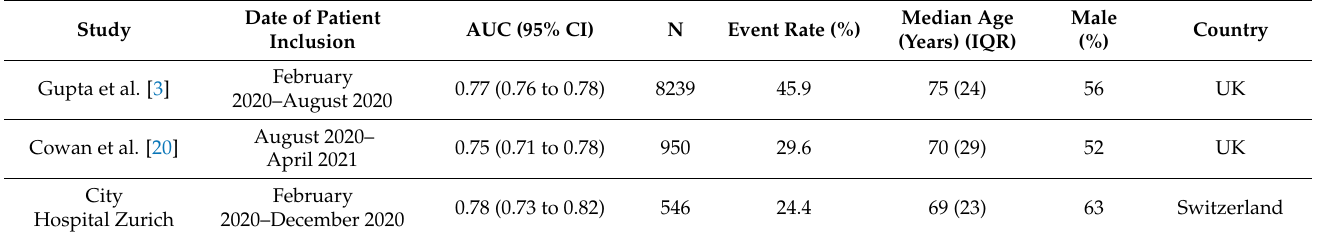
Table 5. Deterioration Model validation performance compared to original Model.